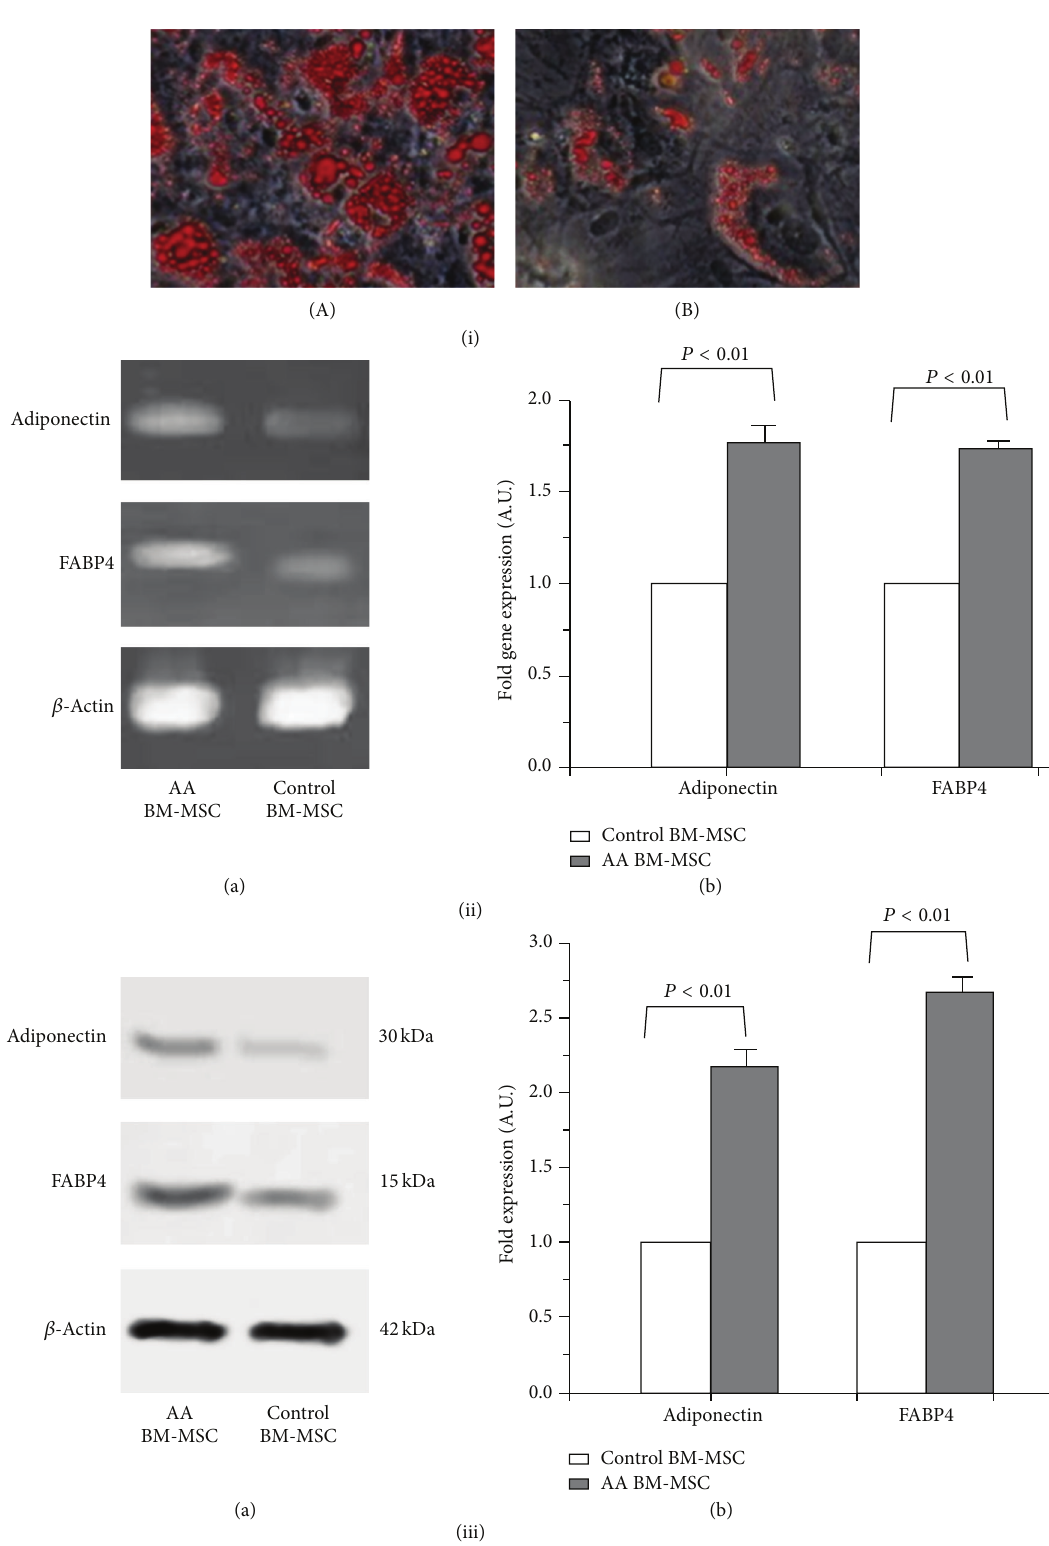
Figure 2: Adipogenic and osteogenic differentiation of BM-MSCof aplastic anemia patients. (i) Oil red O staining of adipocytes differentiated from BM-MSC of (A) aplastic anemia patients and (B) controls (bright field microscope view at 20x). (ii) Gene expression of adiponectin and FABP4 in adipocytes differentiated from BM-MSC of aplastic anemia patients and controls. (a) Representative gel pictures of RT-PCR. (b) Fold gene expression. (iii) Protein expression of adiponectin and FABP4 in adipocytes differentiated from BM-MSC of aplastic anemia patients and controls. (a) Representative Western-blot picture. (b) Fold expression of